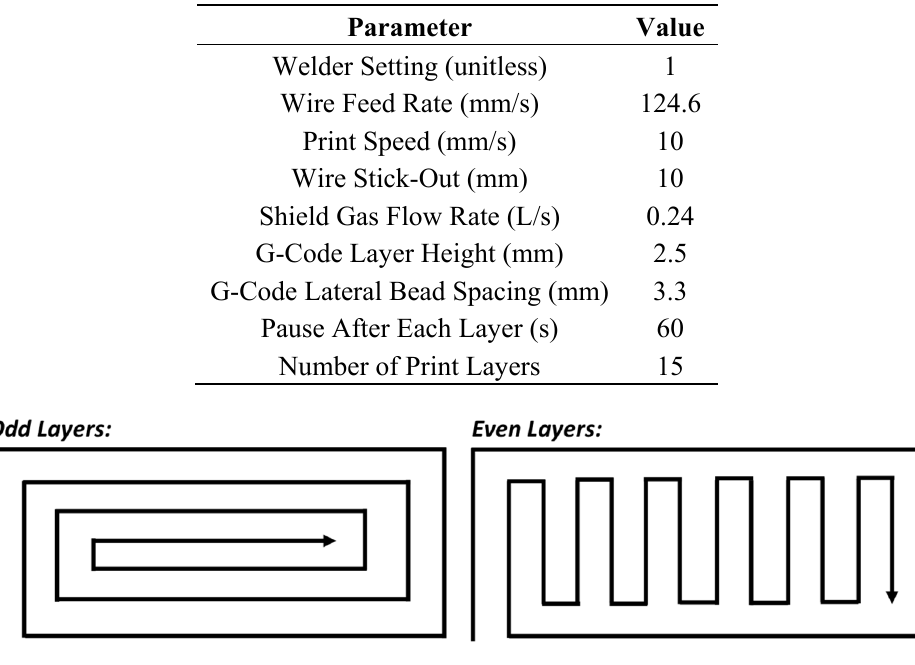
Table 2. Print Settings Utilized for Test Specimens.